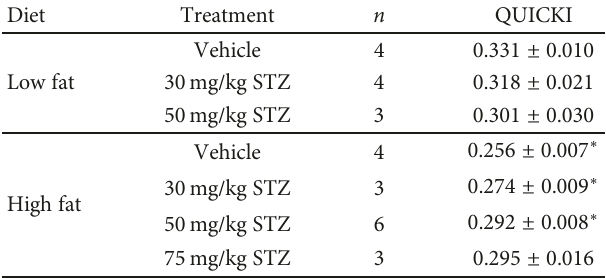
QUICKI = 1/ log I 0 + log G 0 , where I 0 is fasting insulin and G 0 is fasting glucose. Data are means ± SEM . ∗ p < 0 05 versus low-fat